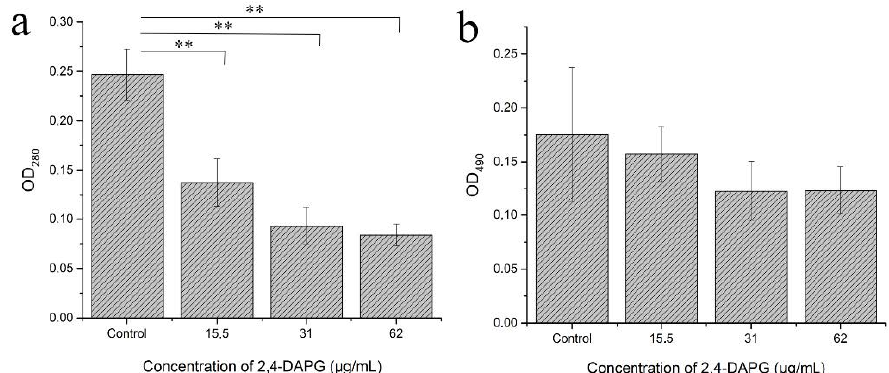
Figure 3. Protein ( a ) and carbohydrate content ( b ) in EPS of C.albicans biofilms which were formed under the 2,4-DAPG treatment for 24 h. The y-axis represents absorbance units. The means plus standard deviations of results from two independent experiments with three technical replicates are shown. Values that are significantly different from the values for “control” are indicated ** p < 0.01 (pair-sample Student’s t -test).